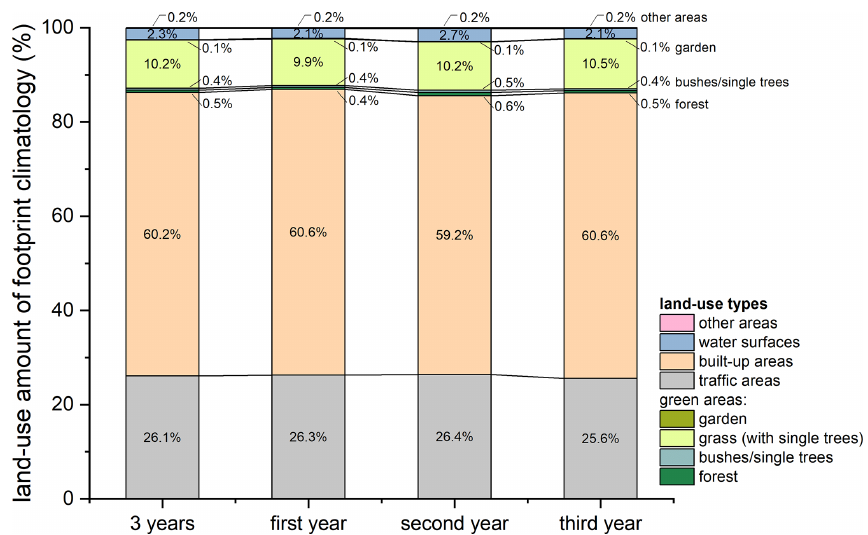
Figure 5. Amount of land use contributing to the flux footprint climatologies separated according to the different time periods of measure- ment. For data analysis, the footprint information in a 4km × 4km grid centred on the measurement site was used (4m spatial resolution). This footprint area completely includes the 80% contour line. Table 3. Mean, median, minimum, and maximum F TNC and F UFP for the 3 measurement years and the four meteorological seasons